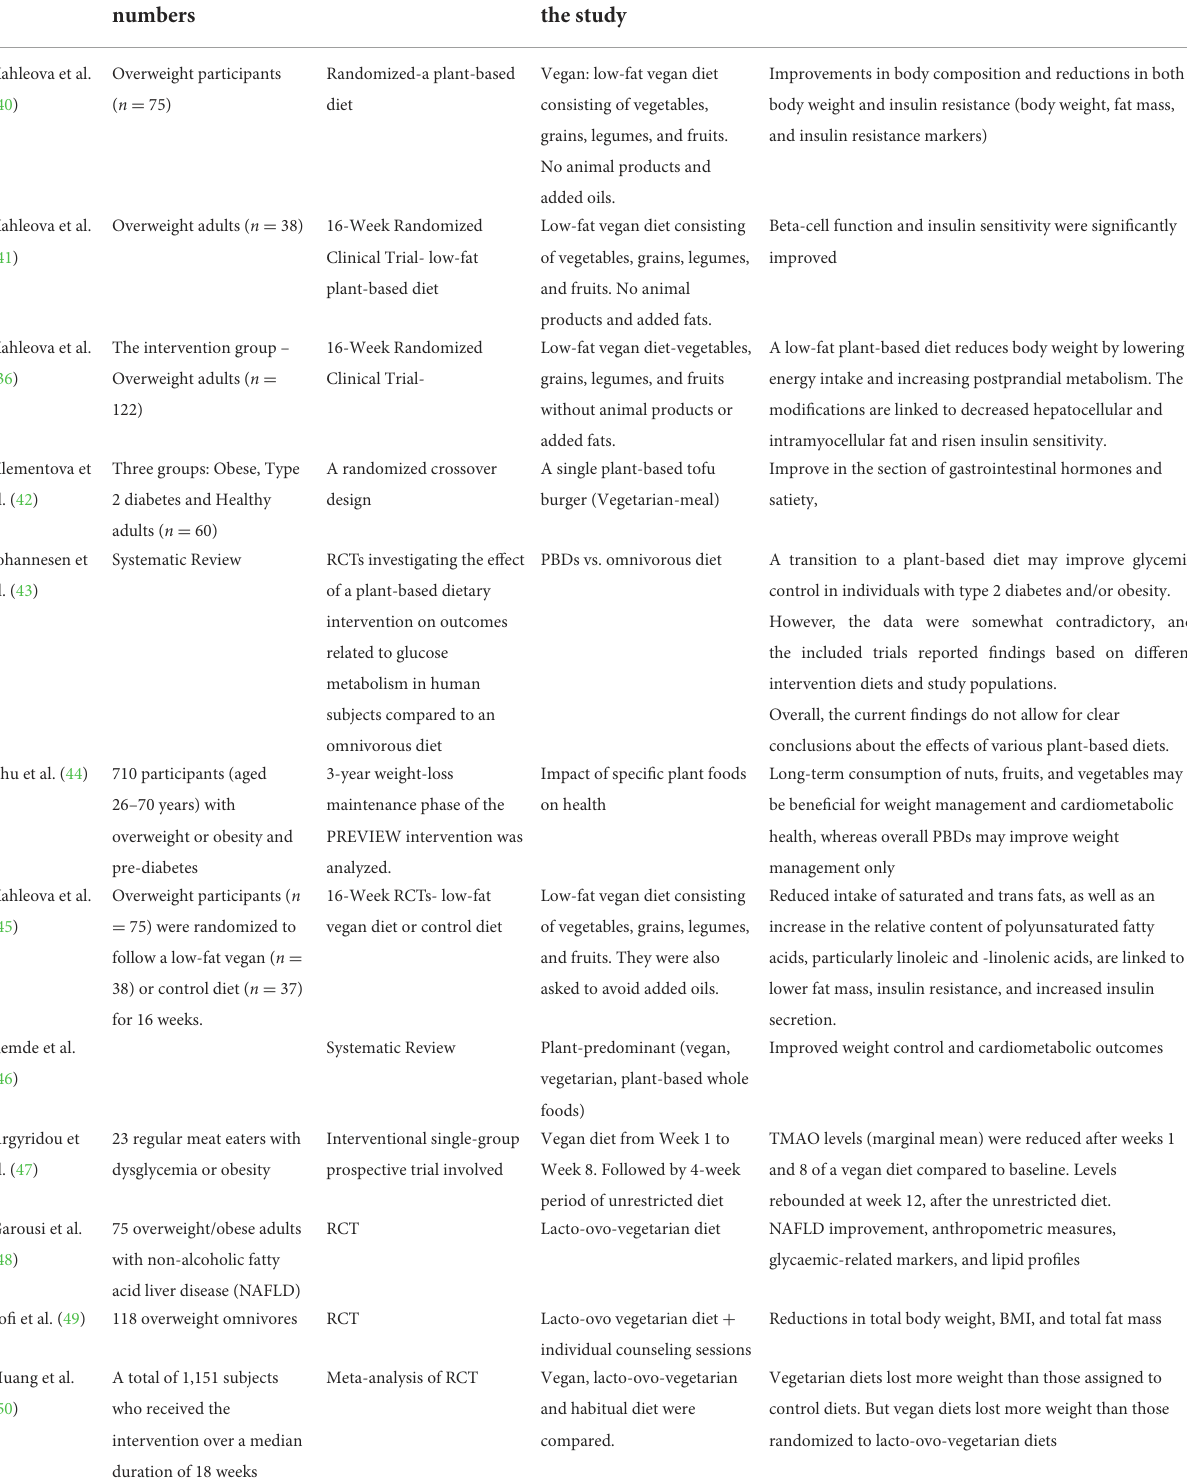
TABLE 1 Selected studies on the metabolic/health outcome of plant-based diets (PBDs)– among overweight/obese